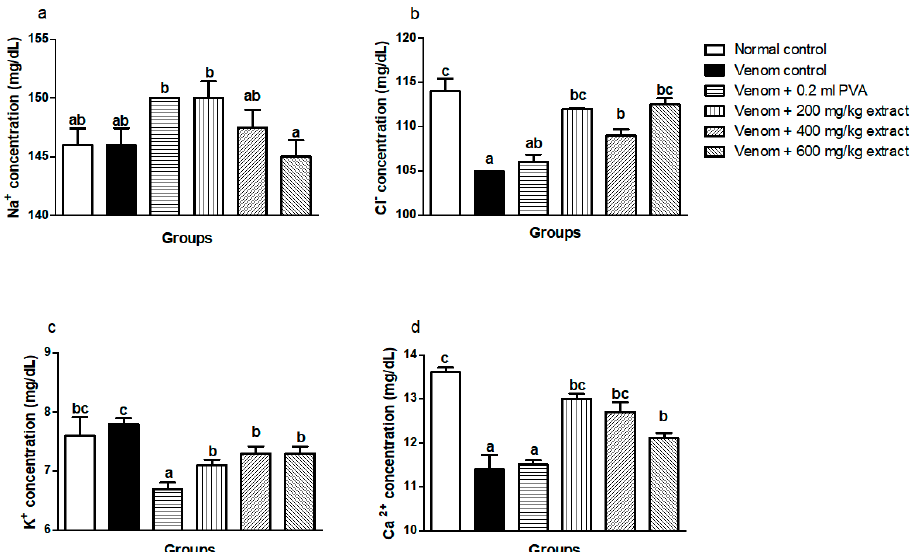
Figure 1. Effects of M. oleifera ethanol extract on electrolytes levels of rats challenged with E. ocel- latus venom. Data are expressed as mean ± SD ( n = 3). Bars with different letters are statistically distinct ( p < 0.05). ( a ) Na + concentration; ( b ) Cl + concentration; ( c ) K + concentration; ( d ) Ca 2+ concentration. PVA: polyvalent antivenom; Na + : sodium ion; K + : potassium ion; Cl − : chloride ion; Ca 2+ : calcium ion.